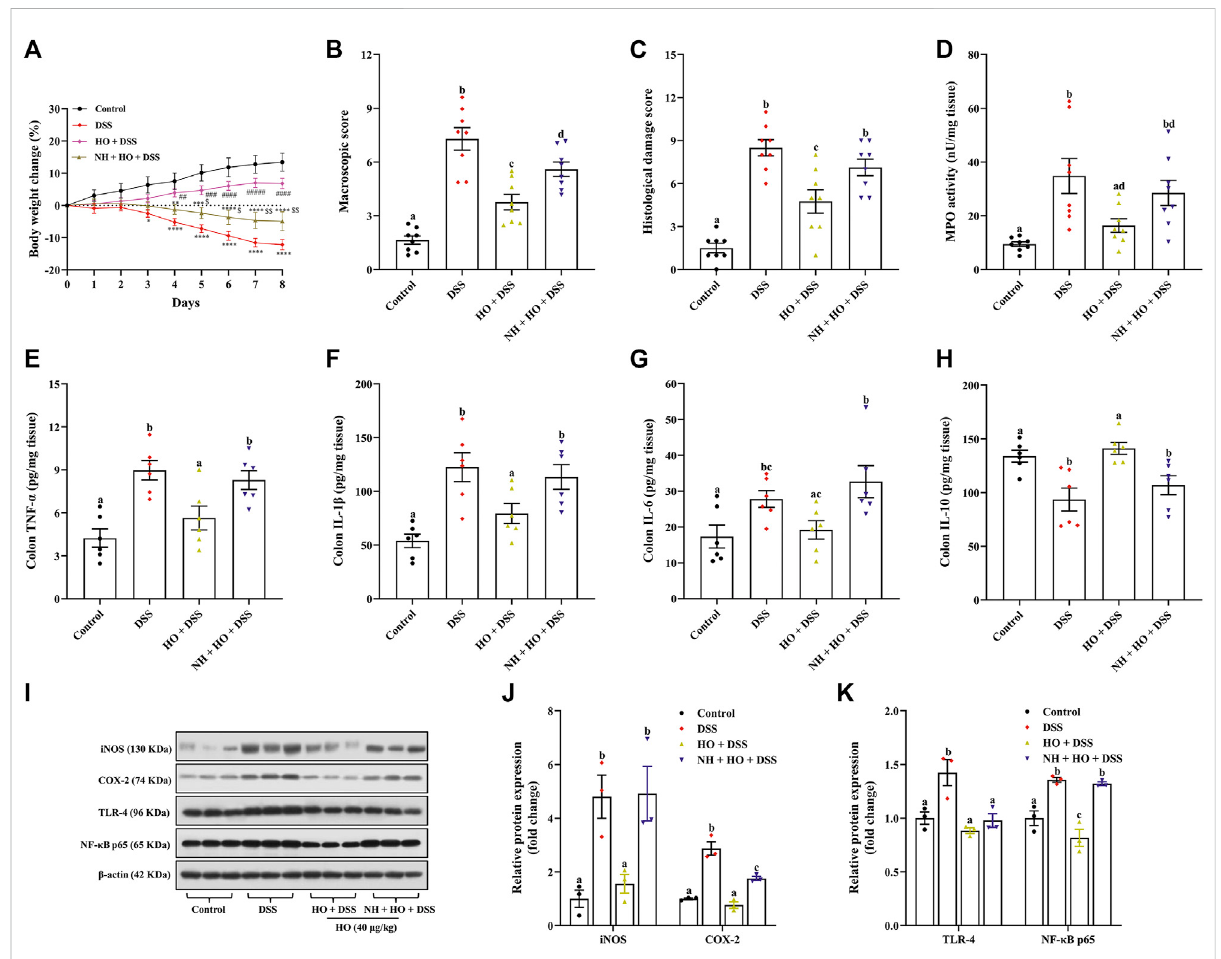
FIGURE 4 HOexhibitsanti-in fl ammatoryeffect inDSS-exposed micebyactivating theopioidpathway. (A) Bodyweightchange. (B) Macroscopicdamage score. (C) Histological damage score. (D) MPO activity. (E) Colon TNF- α level. (F) Colon IL-1 β level. (G) Colon IL-6 level. (H) Colon IL-10 level. (I) Western blotanalysis of iNOS, COX-2, TLR-4, and NF- κ Bexpression in thecolon. (J) Quantitativeanalysis ofthe relativecontents ofiNOS and COX- 2. (K) QuantitativeanalysisoftherelativecontentsofTLR-4 andNF- κ B.Thedataareexpressedasmean±S.E.M.( n =3 – 8).* p < 0.01,** p < 0.01, *** p < 0.005, **** p < 0.0001 vs. control group, ## p < 0.01, ### p < 0.005, #### p < 0.0001 vs. DSS group, and $ p < 0.01, $$ p < 0.01 vs. HO + DSS group, one-way ANOVA with Tukey ’ s multiple comparisons test. Bars with different letters represent signi fi cant differences between groups by Fish ’ s LSD test ( p <